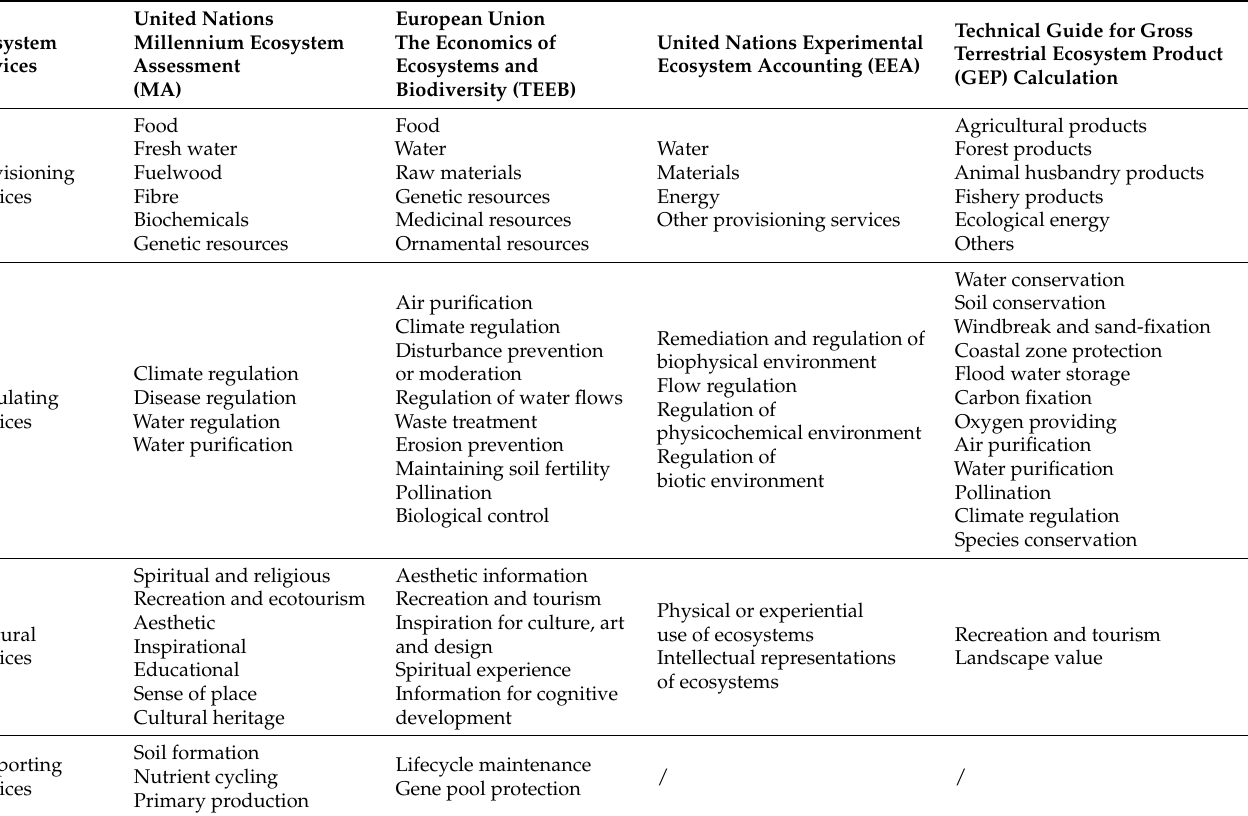
Table 1. List of ecosystem services value evaluation indices in other relevant